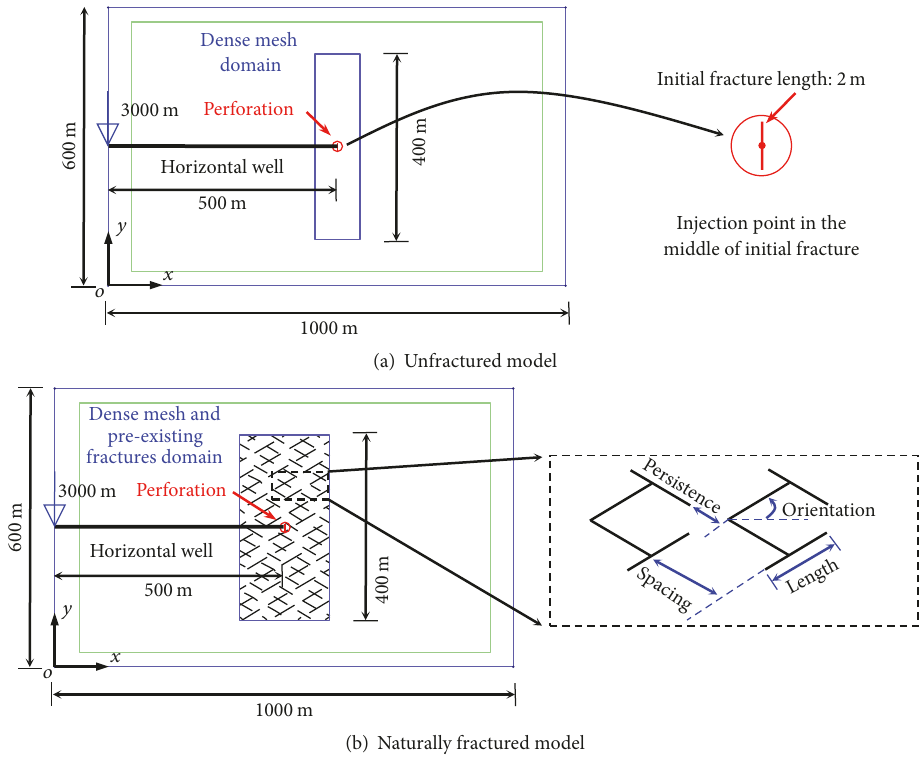
Figure 3: Geometrical models of staged hydraulic fracturing in perforated horizontal well.